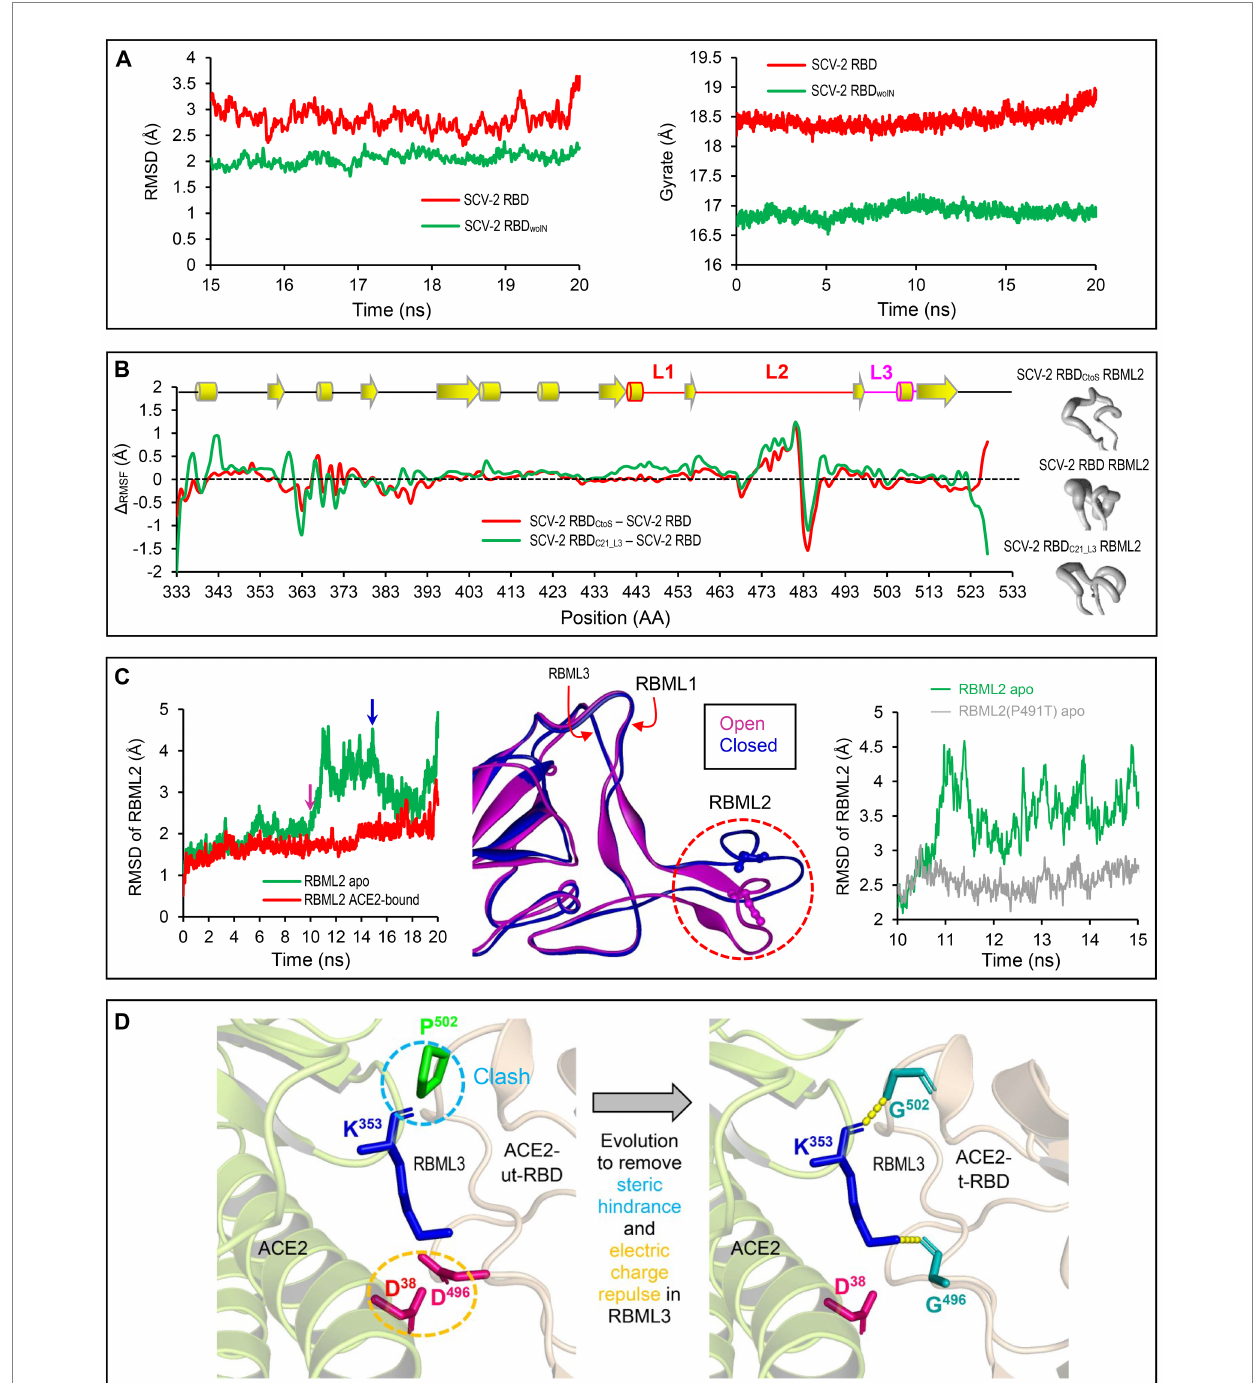
FIGURE 4 Structural and dynamics evidences for ACE2 binding origin. (A) Backbone-RMSDs of SARS-CoV-2 RBD and its deletion mutant shown as a function of time (left). Gyrate of proteins. SARS-CoV-2 RBD and its deletion mutant shown as a function of time (right). (B) Δ C α -RMSF data. SARS-CoV-2 RBDCtoS – SARS-CoV-2 RBD is marked in red and SARS-CoV-2 RBDC21_L3 – SARS-CoV-2 RBD in green (left). Conformational ensembles of RBML2 generated by MD simulations and shown by a “sausage” model with MOLMOL (right). (C) A 20-ns MD simulations showing structural dynamics of RBML2 in the apo state or ACE2-bound sate (left). Snapshots extracted from the MD trajectories at 10 and 15 ns, respectively, showing two distinct conformations in RBML2 (open and closed; middle). Comparison of the RBML2 RMSDs between SARS-CoV-2 RBD and the P491T mutant (right). (D) Structural mapping showing parallel molecular evolution removing steric hindrance and electric charge repulse present in the ancestral state. The clash occurs between Pro-502 of RBDs incapable of binding ACE2 and Lys-353 of ACE2, indicated by a cyan dashed circle, and the electric charge repulse between Asp-496 of the RBDs incapable of binding ACE2 and Asp-496 of ACE2, indicated by an orange dashed circle. In the RBD-hACE2 complex, hydrogen bonds are shown by yellow dashed lines and involved residues displayed as